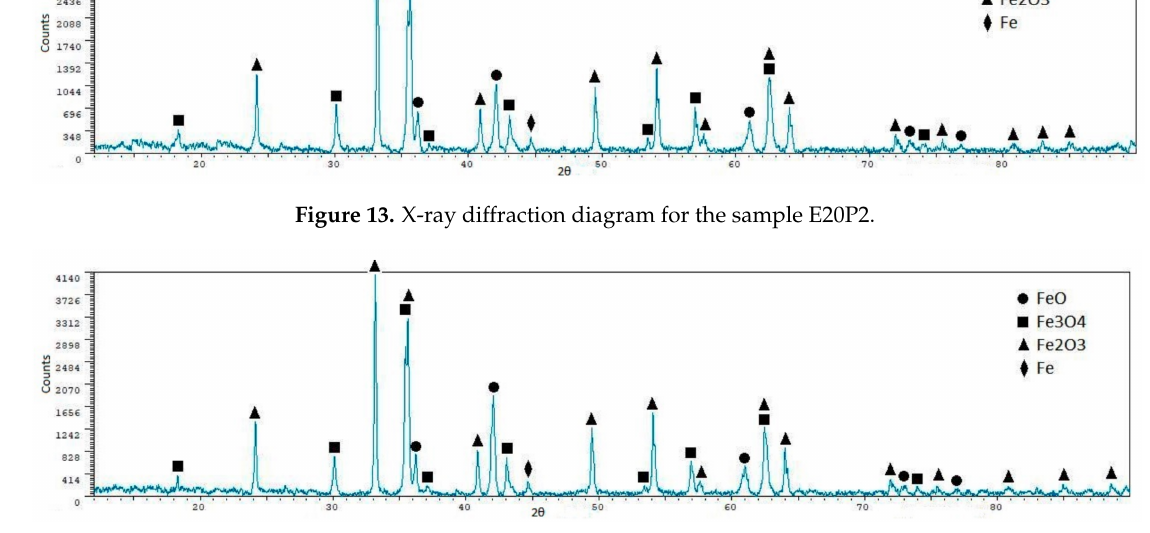
Figure 14. X-ray diffraction diagram for the sample E20P3.